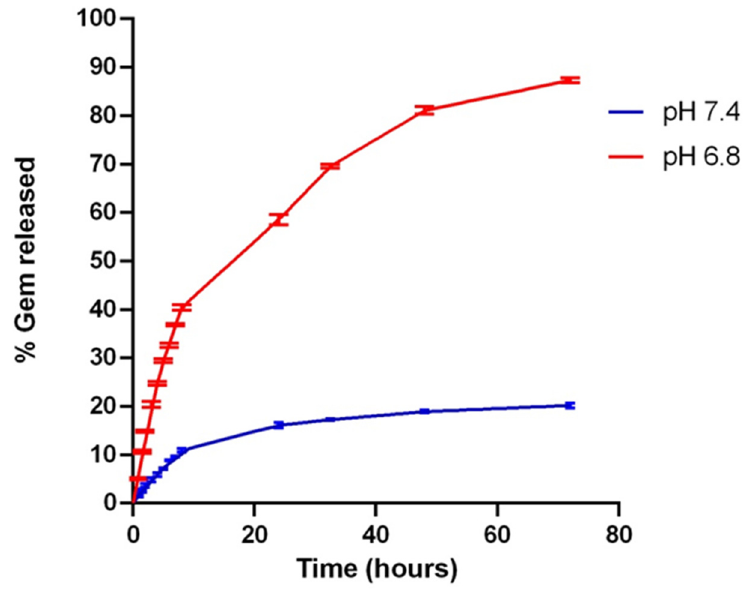
Figure 5. In vitro release profiles of Gem from TpHResMic in PBS at 37 °C at two different pH (6.8